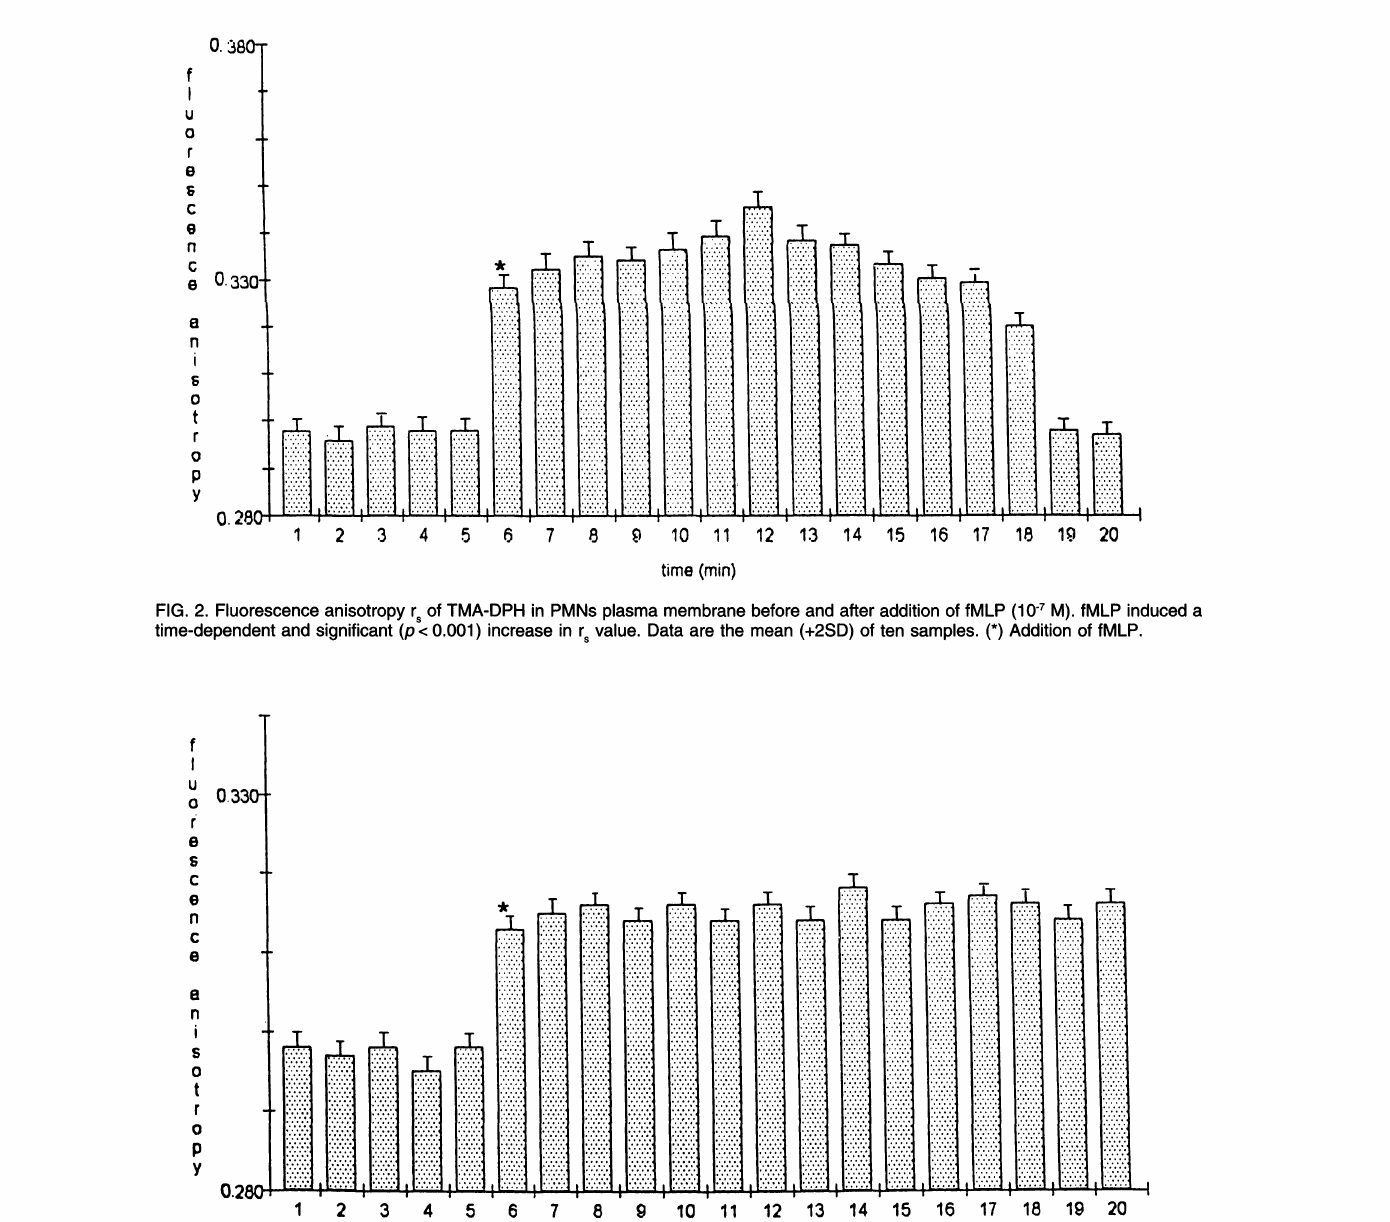
FIG. 2. Fluorescence anisotropy of TMA-DPH in PMNs plasma membrane before and after addition of fMLP (10 M). fMLP induced a time-dependent and significant (p < 0.001) increase in value. Data are the mean (+2SD) of ten samples. (*) Addition of fMLP.